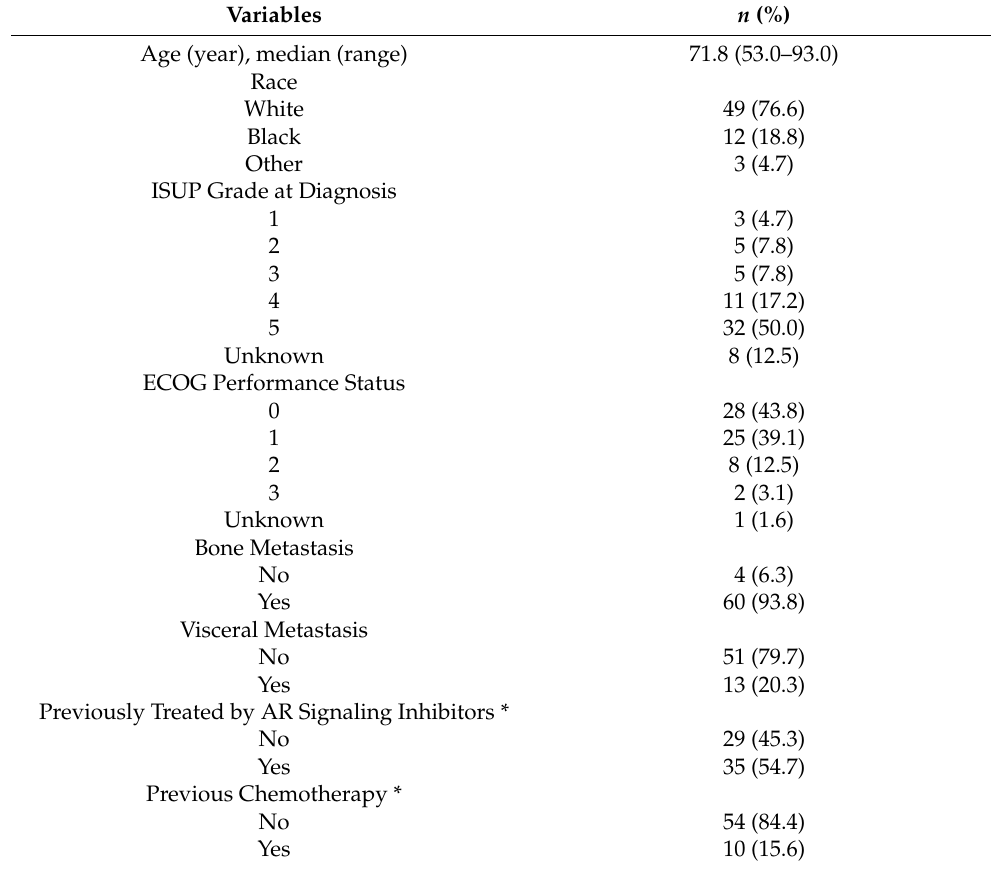
Table 1. Patient characteristics †